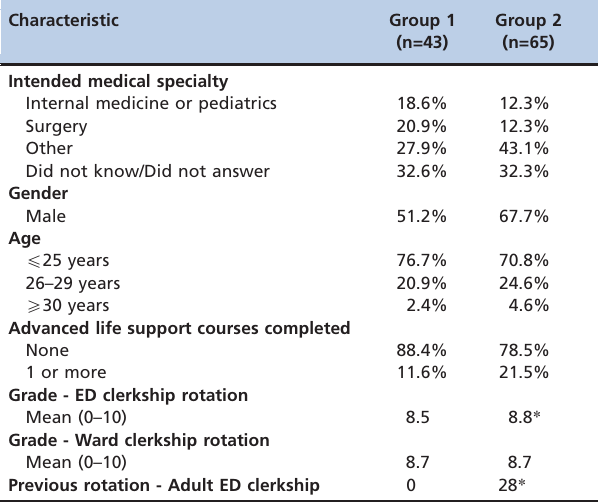
Table 2 - Demographic and educational